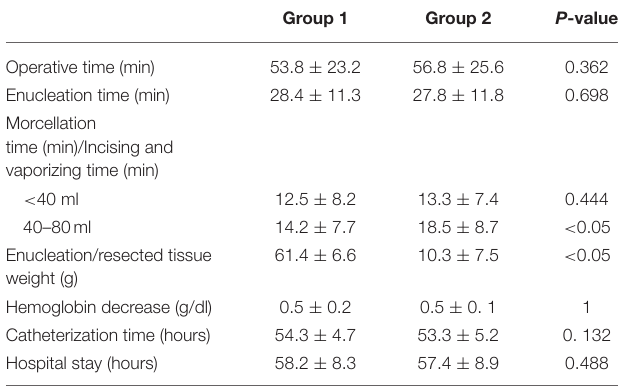
TABLE 2 | Perioperative data between 2